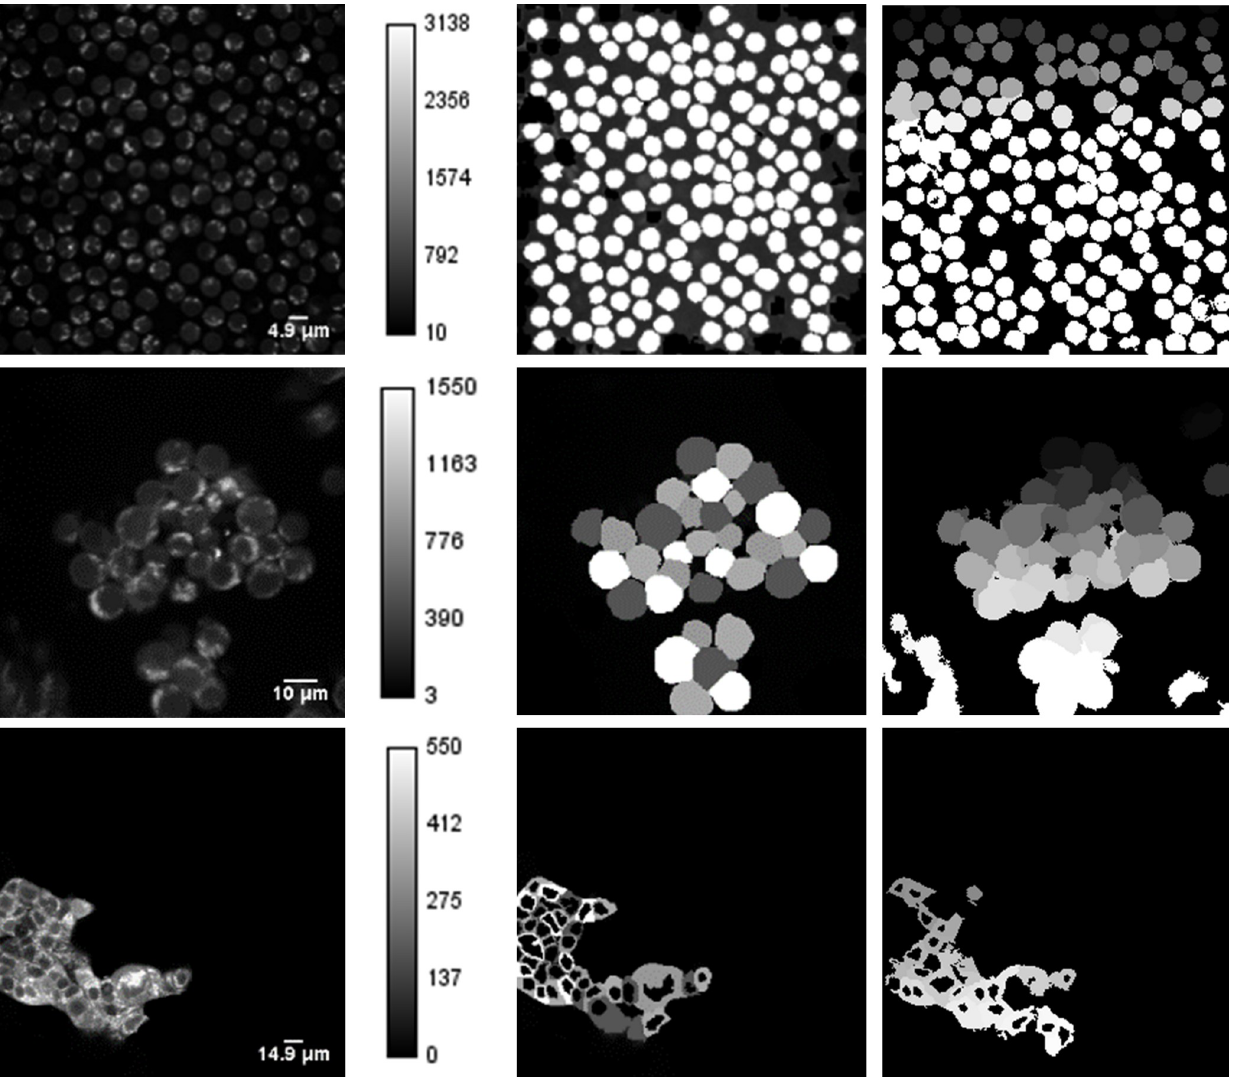
Fig 4. Representative fluorescence (first column) images, ground truth segmented images (second column), and CellProfiler segmented images (third column) of quiescent T cells (first row), activated T cells (second row), and MCF7 cells (third row). Quiescent and activated T cells are segmented into individual cells whereas MCF7 cells are segmented into the